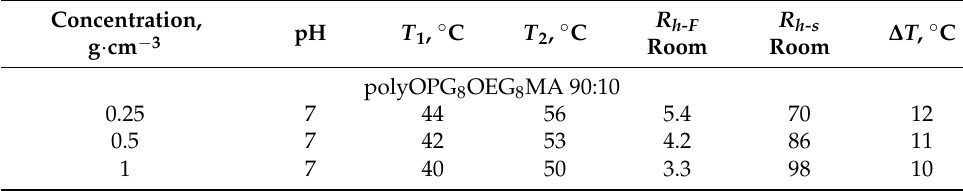
Table 4. Phase separation temperatures for polyOPG 8 OEG 8 MA 90:10.